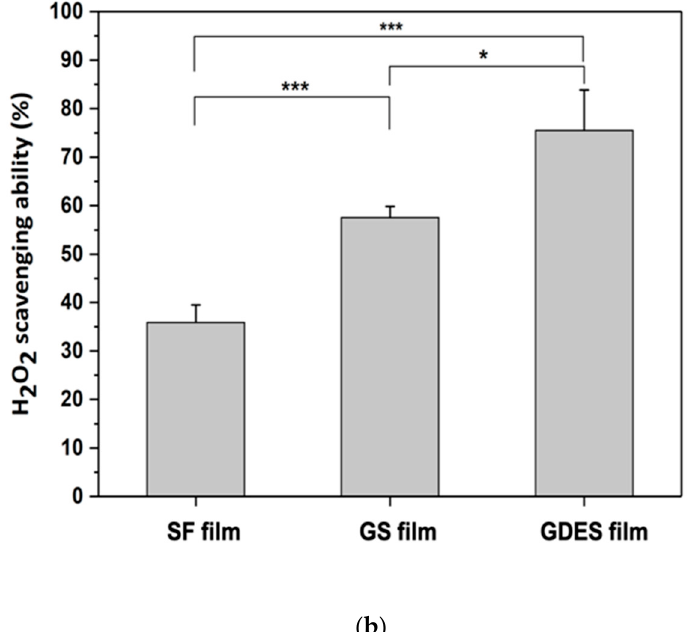
Figure 4. H 2 O 2 scavenging ability tested by using 1, 10-phenanthroline agent to measure the residual H 2 O 2 after immersed GDES films fully scavenged H 2 O 2 in the solution. The 0% scavenging ability was defined as the measurement VIS values using the agent to examine the residual H 2 O 2 without adding any film to scavenge H 2 O 2 , ( a ) H 2 O 2 scavenging ability for GDES films at various temperatures, and ( b ) H 2 O 2 scavenging ability for various films at 37 °C. The ability of GDES films was the highest compared with that for SF and GS films at 37 °C. (Note: * p < 0.05, ** p < 0.01, *** p < 0.001; Data are mean ± SD, n = 3).